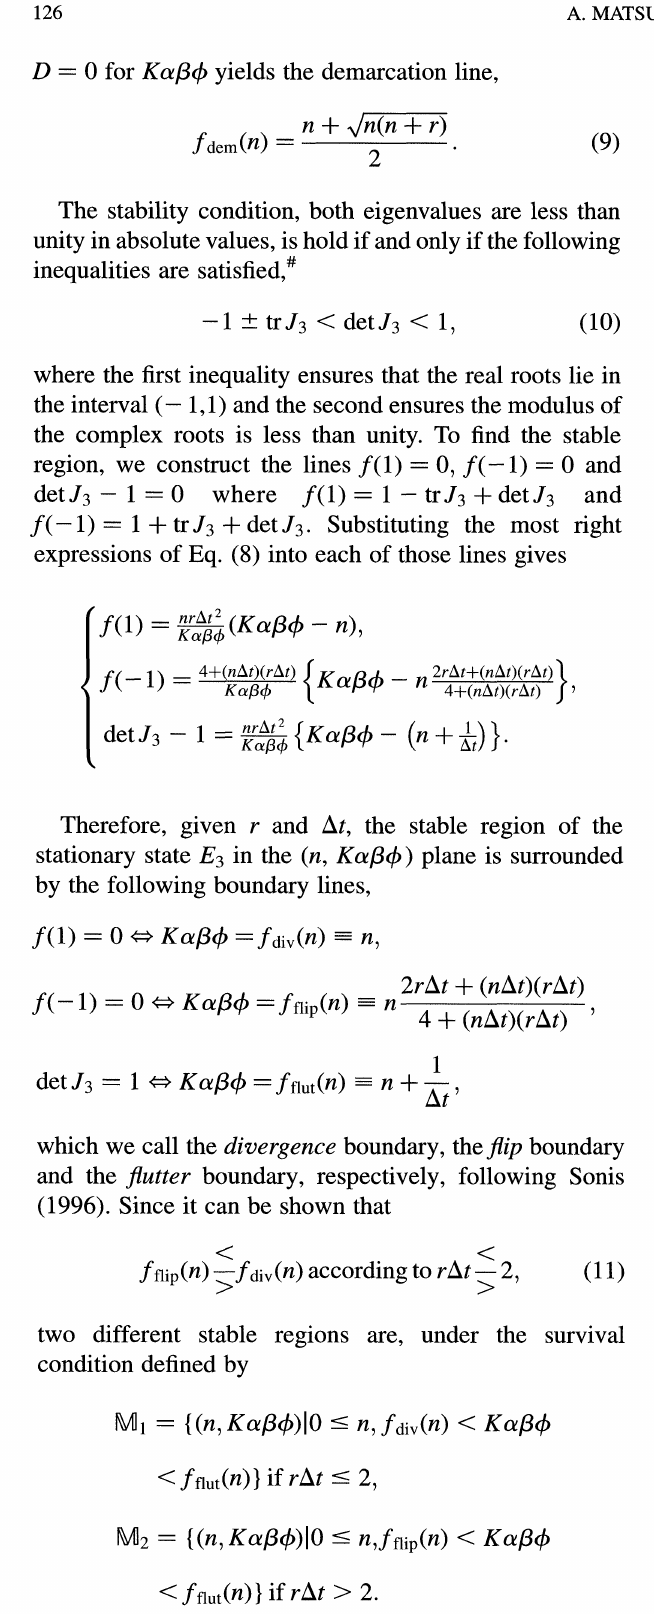
the dark-shaded region), the eigenvalues are real so